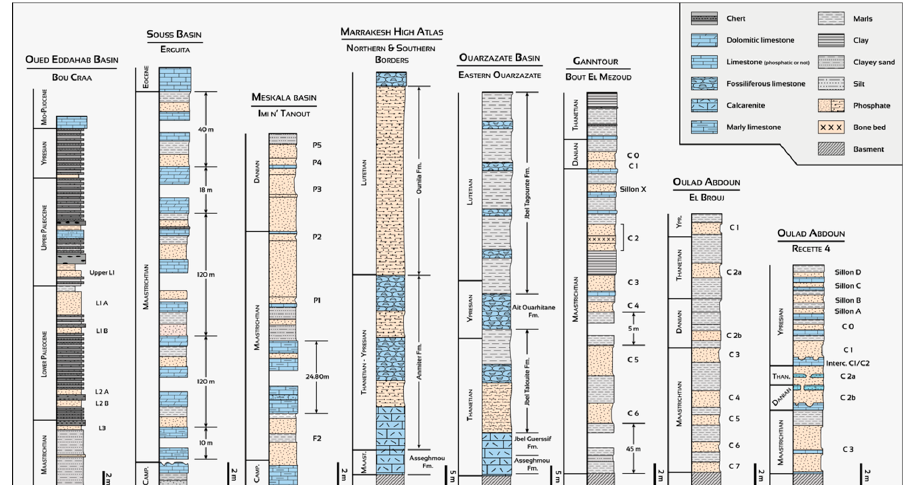
Figure 6. Stratigraphic framework of the Moroccan phosphate series in different basins. Phosphatic layers are intercalated with non-phosphatic sediments of various lithologies. Note that numbers of phosphatic layers are not equivalent in different basins—layer C2 in Ouled Abdoun is Danian–Thanetian, while layer C2 in Ganntour dates from the Upper Maastrichtian. Compiled from [94–97].